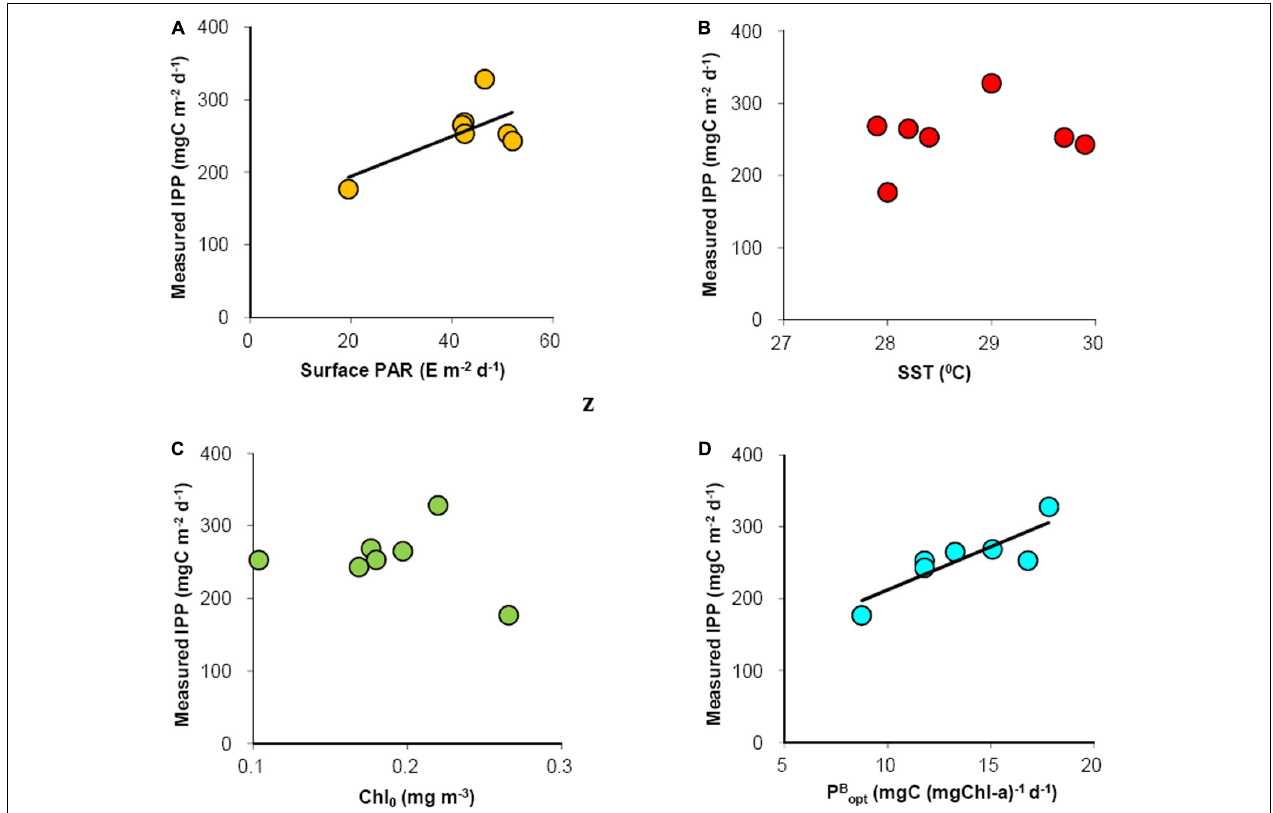
FIGURE 7 | Linear relationships between measured IPP and (A) surface PAR ( r 2 = 0.41, p < 0.05), (B) SST, (C) Chl 0 , and (D) P B opt ( r 2 = 0.73, p < 0.05). Trend line for figure b and c are not shown due to absence of any clear trend.